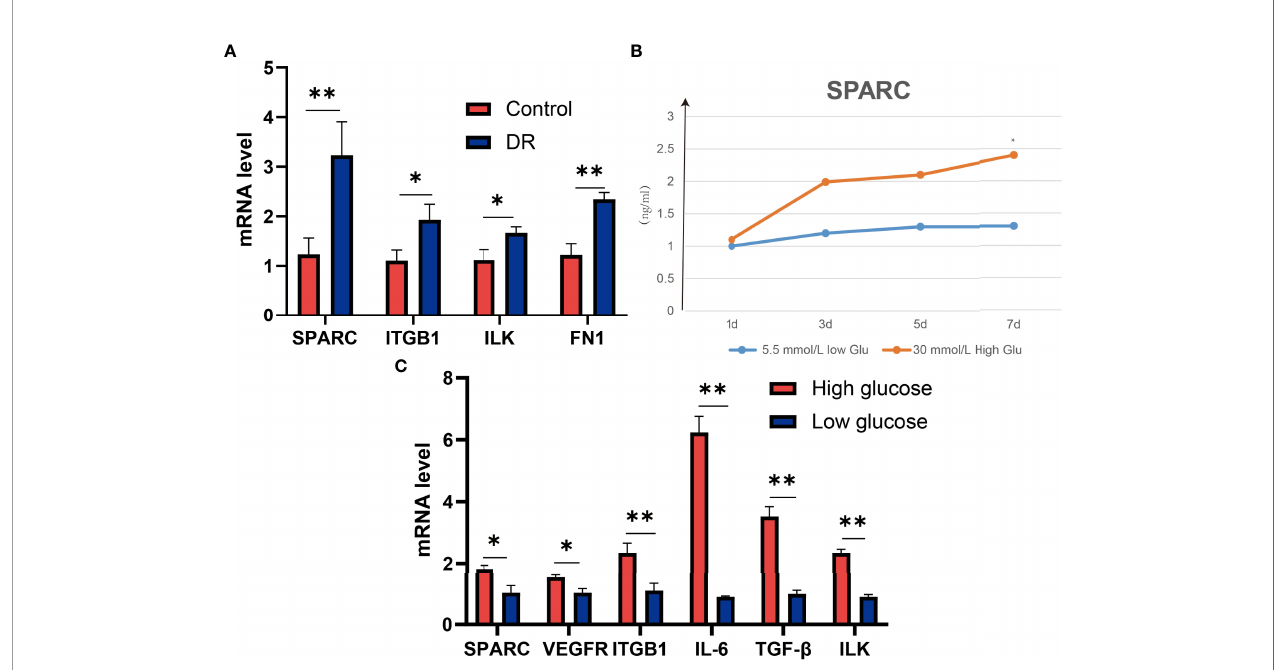
FIGURE 3 | SPARC regulates the expression of ITGB1, in fl ammation, and VEGF genes in high-glucose-induced HECEC cells. (A) The mRNA expression of SPARC, ITGB1, ILK, and FN1 in DR and control tissues. (B) SPARC level in different glucose-induced HECEC cells. (C) The mRNA expression in different glucose-induced HECEC cells. * p < 0.05,** p <